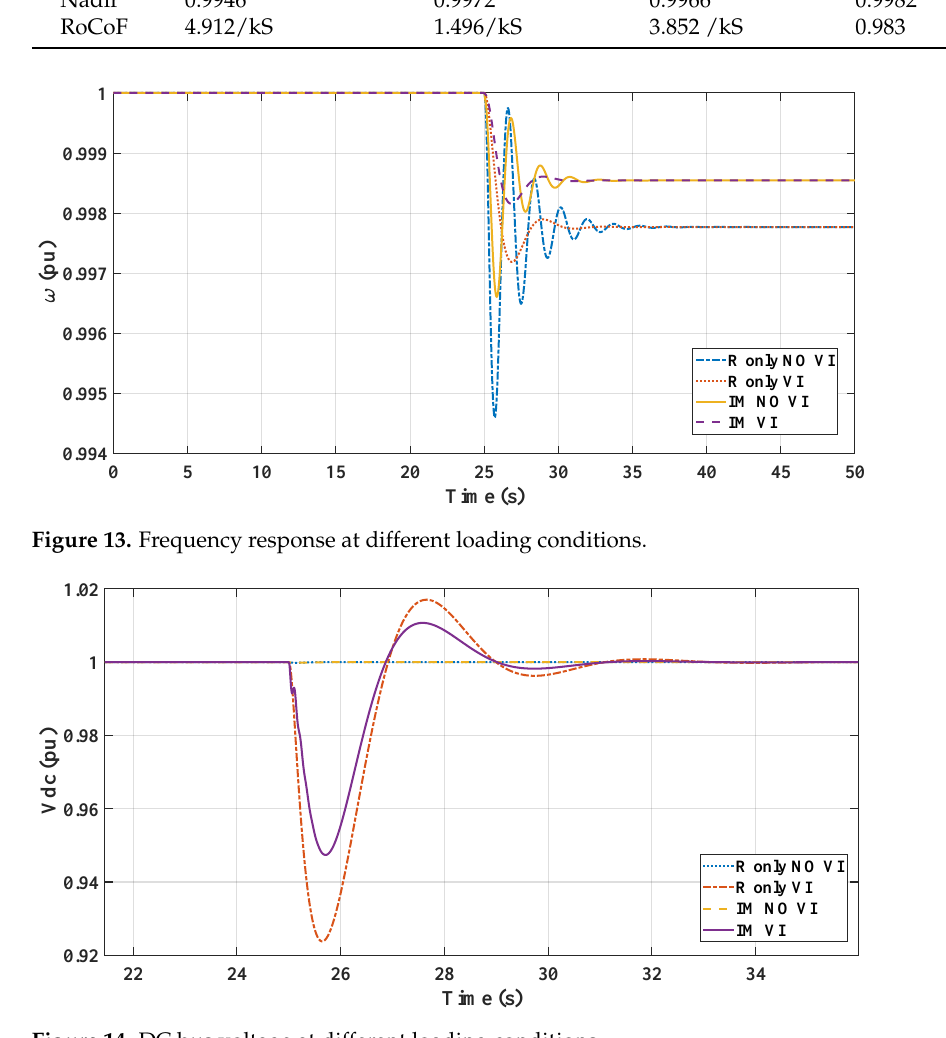
Figure 14. DC bus voltage at different loading